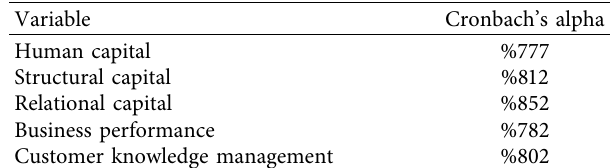
Figure 1: Conceptual model of research. Table 1: Cronbach’s alpha